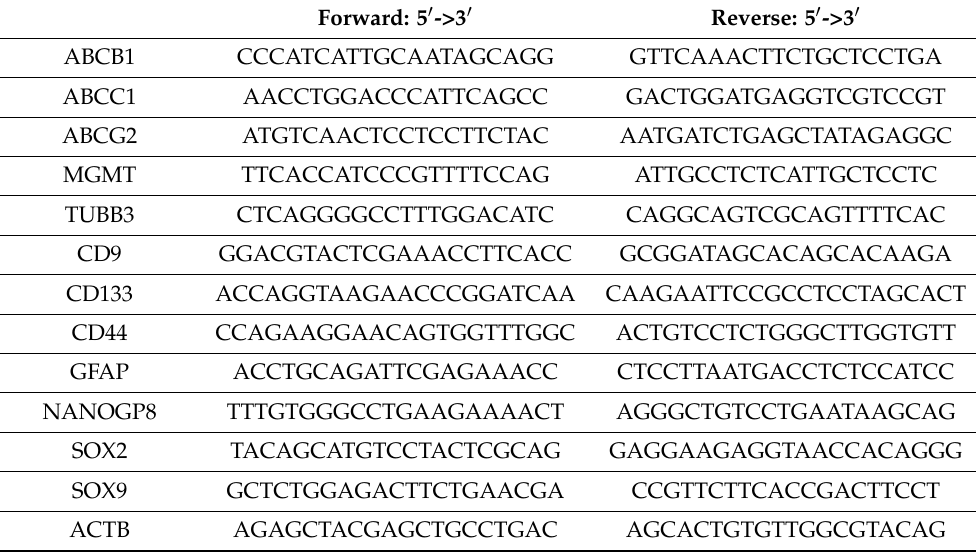
Table 2. Primer sequences used in qPCR of the gene